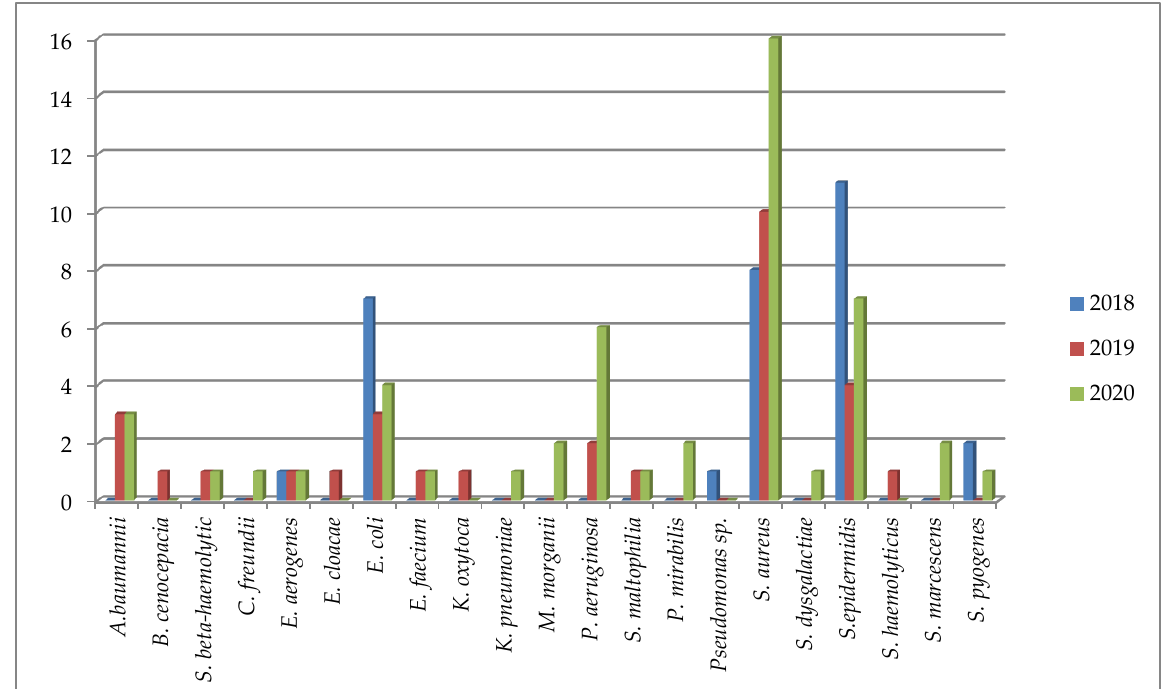
Figure 3. Soft tissue infections etiology structure in Karaganda, Kazakhstan, 2018–2020.